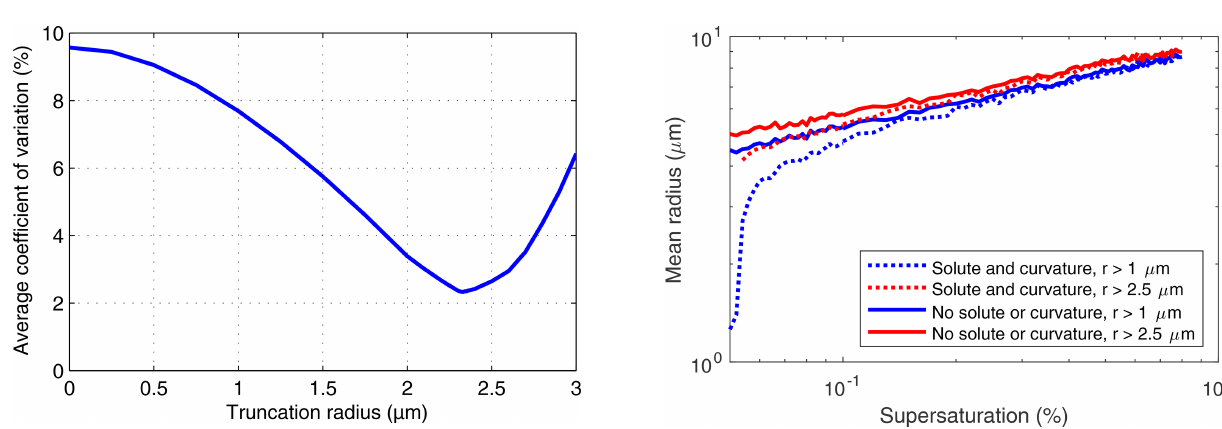
Figure 8. Mean droplet radius versus supersaturation from the Monte Carlo model: with solute and droplet curvature effects (dot- ted lines) and without (solid lines) for all droplets (blue) and ex- cluding droplets with radii < 2 .